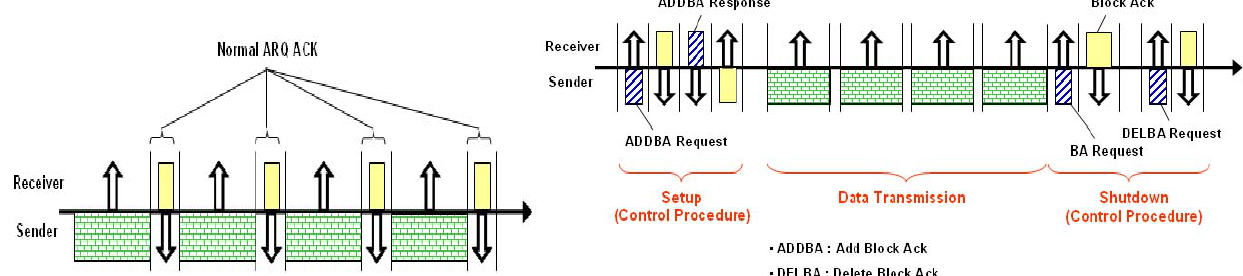
Figure 1. ARQ (left) and BA of IEEE 802.11x (right)